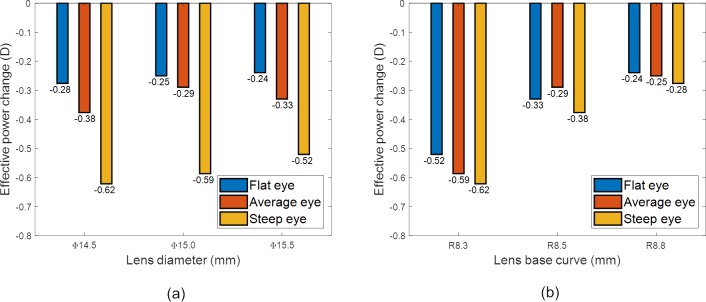
Parametric analysis of toric prescriptions, (a) effect of lens diameter, (b) effect of the lens base curve.